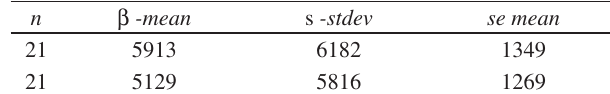
Table 6. Twosample t –Test for C1 vs